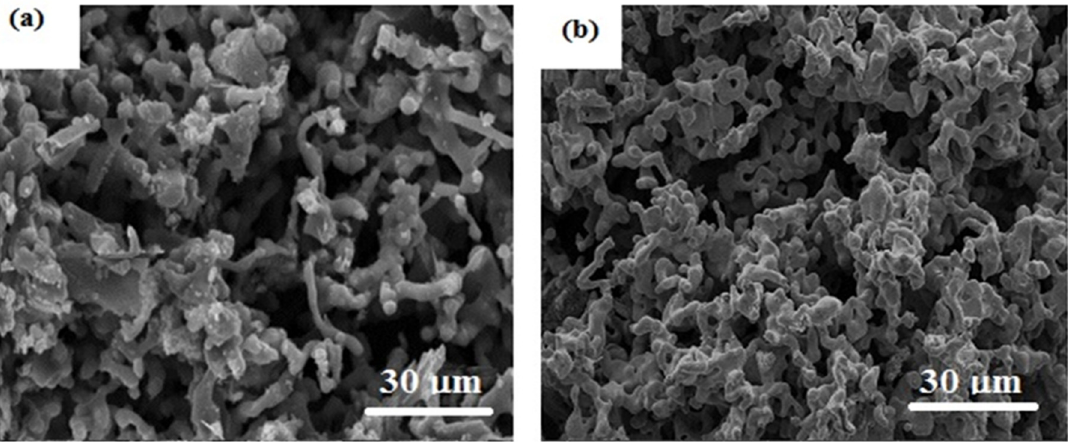
Figure 15. SEM Photo micrographs of Fe 2 O 3 / coal composites reduced at different heating rates: ( a ) 20 °C/min and ( b ) 5 °C/min.